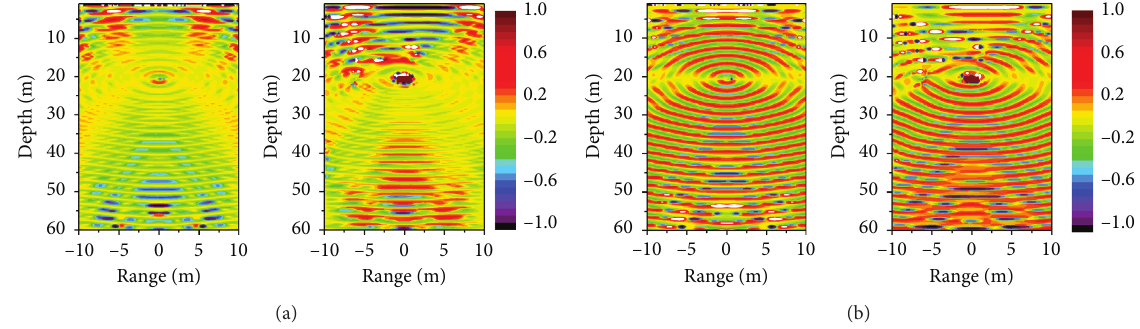
Figure 14: (a) I ∗ z near the source (range from − 10m to 10m. left: point source; right: cylindrical shell) ( f